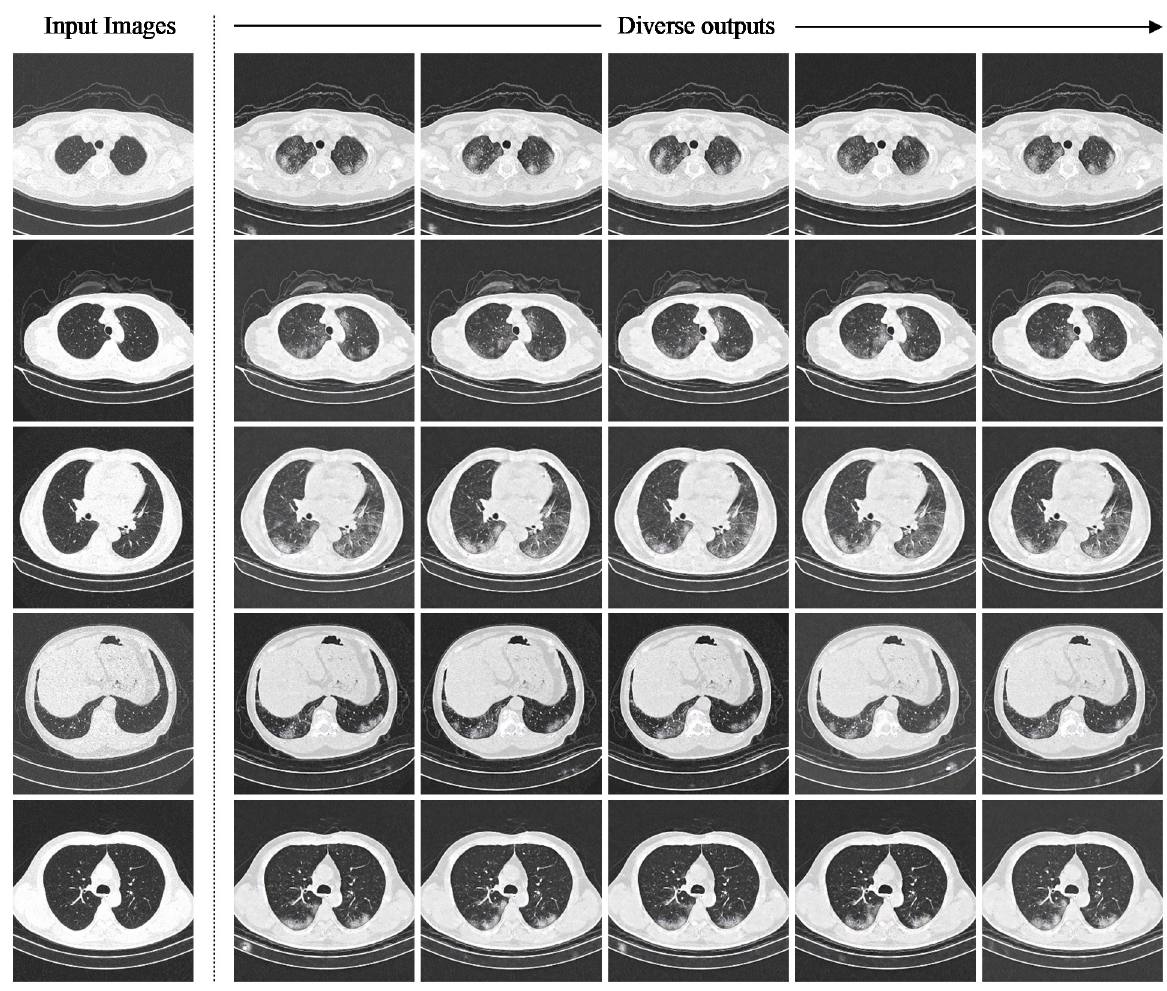
Figure 7. Instance-diverse synthetic images generated from the sRD-GAN with light residual dropout using the same non-COVID-19 inputs in inference mode (0.2 dropout rate). Fine-grained image diversity is consistently observed on the synthetic features of ground-glass opacities (GGOs) generated within the region of the lungs. Other samples are included in Dataset S2.